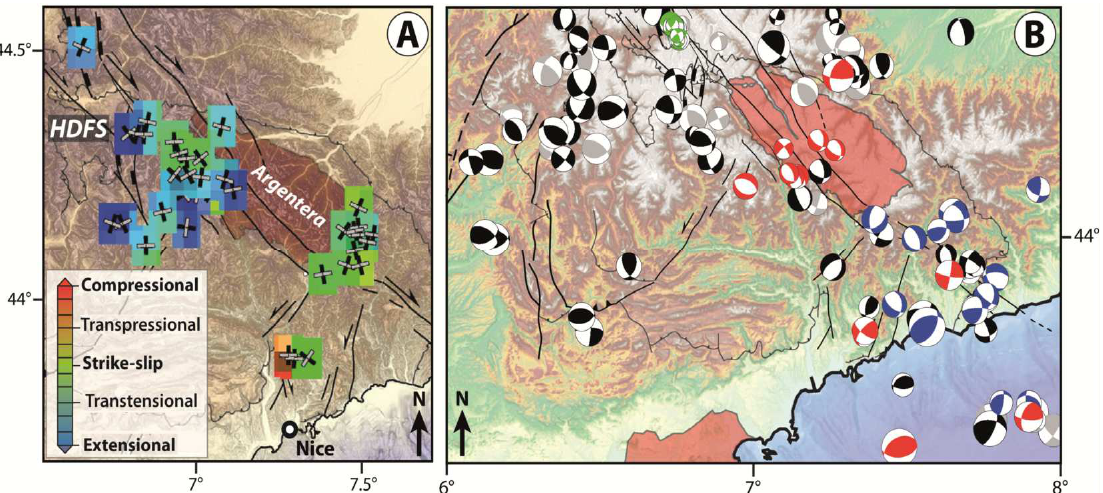
Figure 3. ( A ) Paleostress tensors computed from fault–striae data and ( B ), focal mechanisms of active seismicity from [51]. Note the transition from extension to strike–slip and compression, from NW to SE. HDFS: High Durance Fault System.